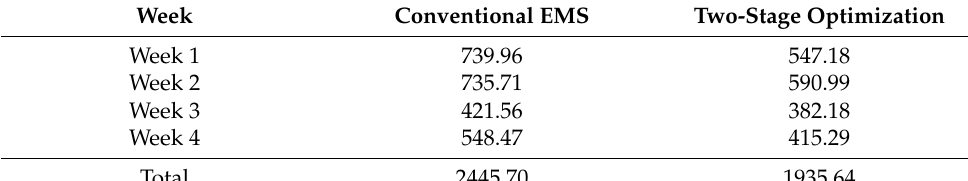
Table 5. CO 2 emissions (g) generated by the connection of the charging station to the grid.